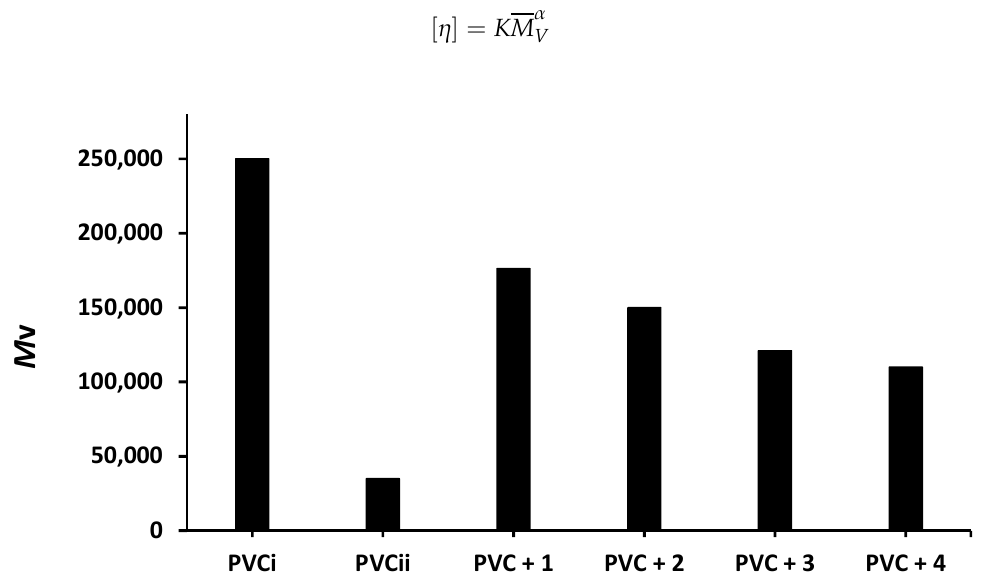
Figure 8. E ff ect of irradiation (300 h) on the M V of PVC films containing tin(IV) compounds 1 – 4 . PVC i Figure 8. Effect of irradiation (300 h) on the 𝑀(cid:3365) (cid:2906) of PVC films containing tin(IV) compounds 1 – 4 . PVC i and PVC ii are the M V of the blank PVC film before and after irradiation, and PVC ii are the 𝑀(cid:3365) (cid:2906) of the blank PVC film before and after irradiation, respectively.